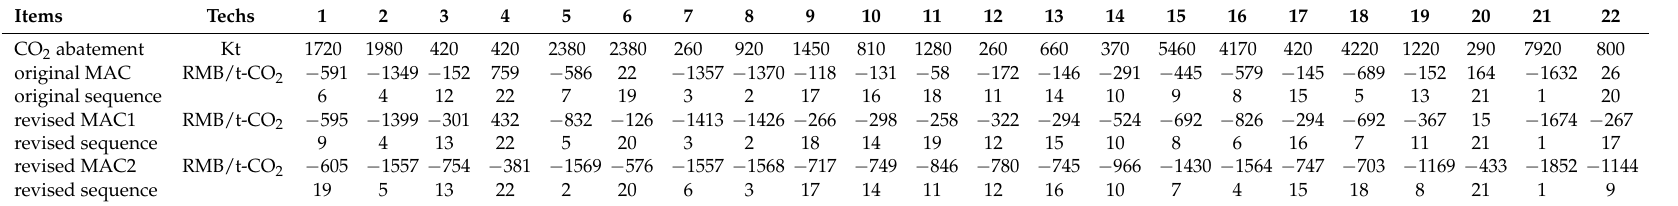
Table 5. Petrochemical industry CO 2 marginal abatement cost